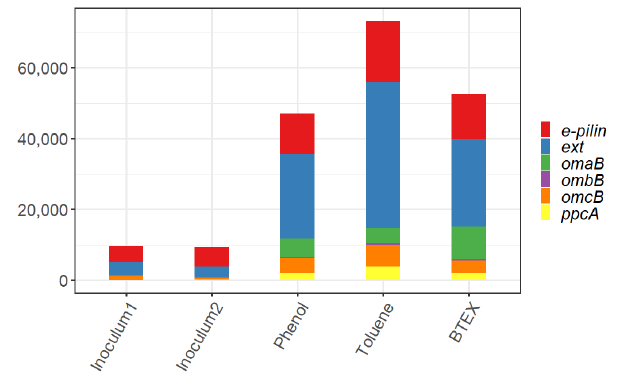
Figure 5. Coverage of genes coding for enzymes related with direct electron transfer (e-pilin (pilA), ext, omaB, ombB, omcB, ppcA) based on the abundances of CDS classified with a custom-made protein database.